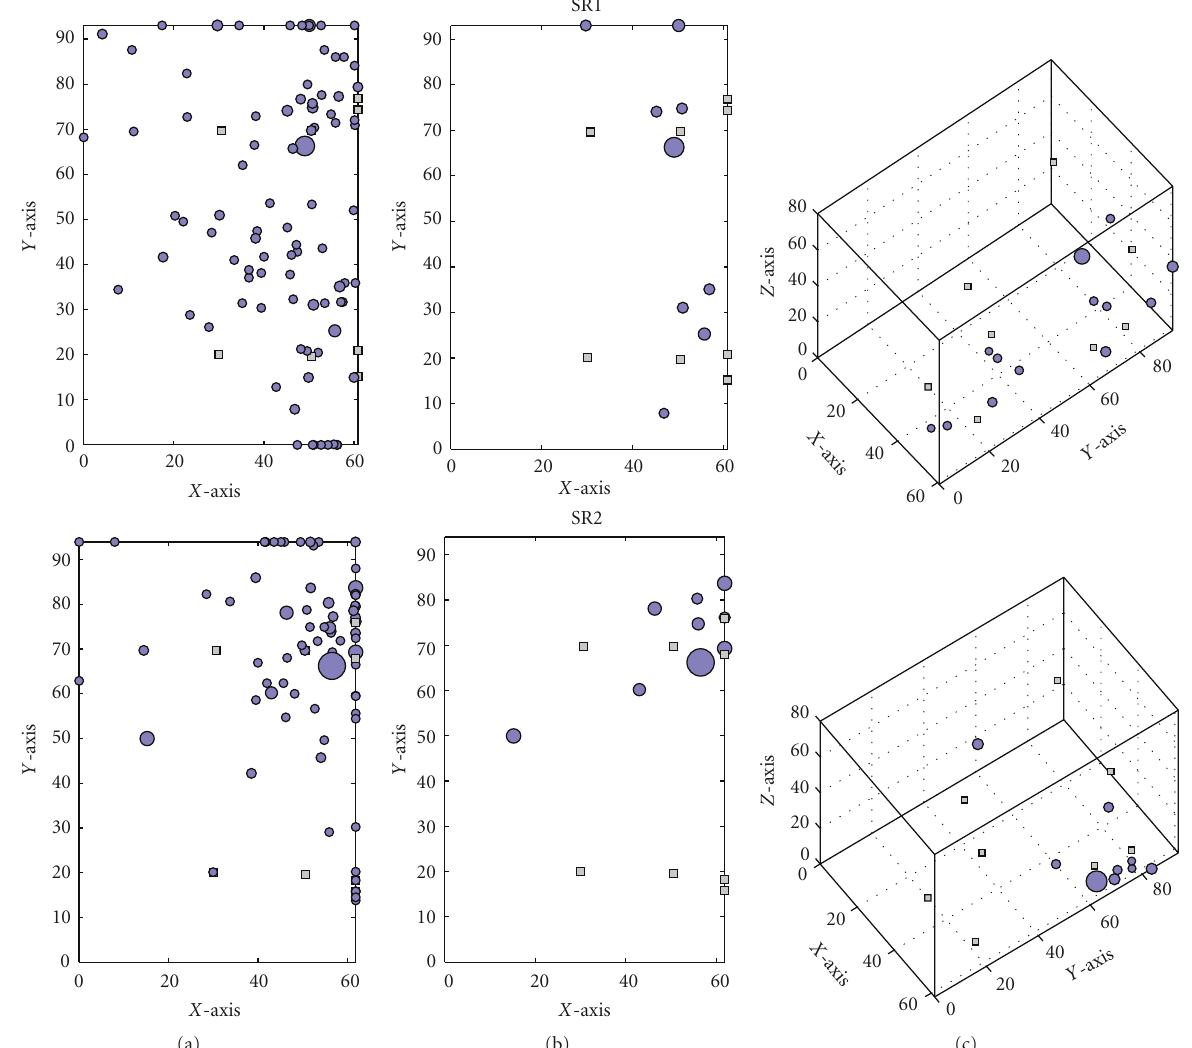
Figure 12: Estimated locations of the AE events for SR1 (first row) and SR2 (bottom row). Each blue circle represents the location of a particular cluster. The diameter of the circle is proportional to the number of AE in the cluster: (a) The locations of all clusters; (b) the locations of those clusters with at least four members. Note that the locations are very close to the free surface; (c) the 3D view of the locations given in the second